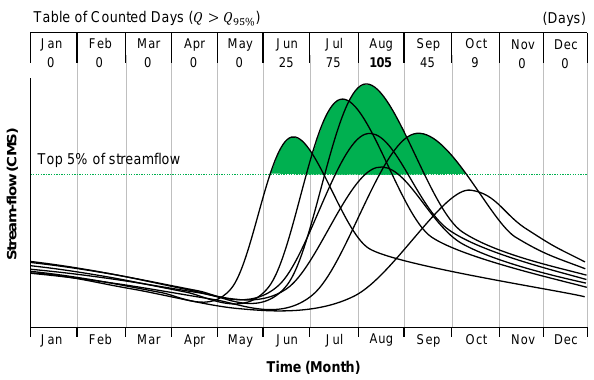
Figure 2. Seven years of synthetic streamflow data. The dotted line represents the 5% streamflow threshold. Numbers indicates the to- tal days above the threshold for each